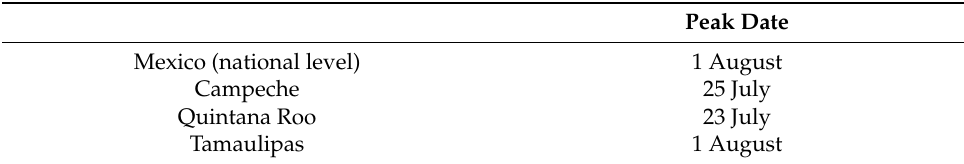
Table 1. COVID-19 peak dates.